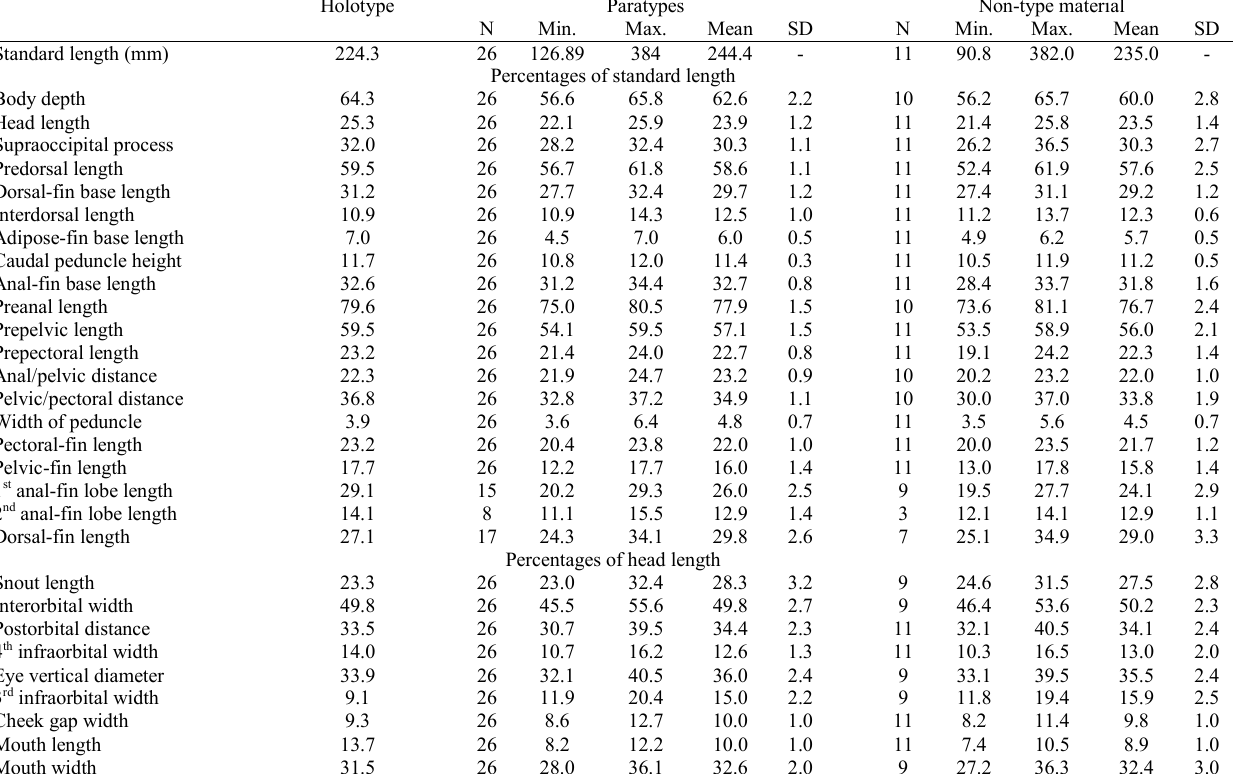
Table 1. Morphometric data for Tometes camunani , new species. Range for paratypes includes holotype. N = number of specimens; Min = Minimal; Max. = Maximal; SD = Standard